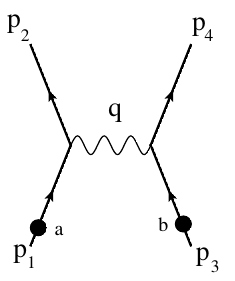
Figure 1 . The graviton exchange diagram between source a and b that yields the leading 1 =q 2 singularity, which is responsible for the classical